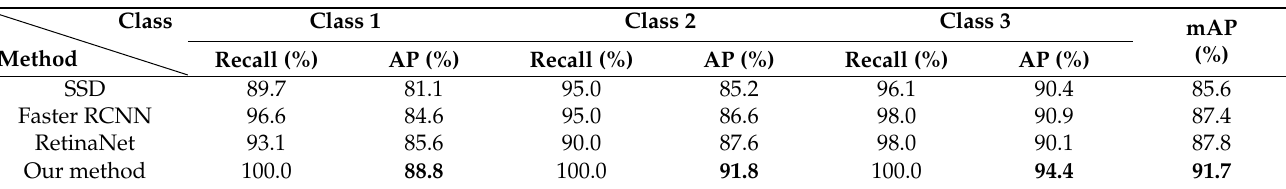
Table 2. Contrast results of disparate